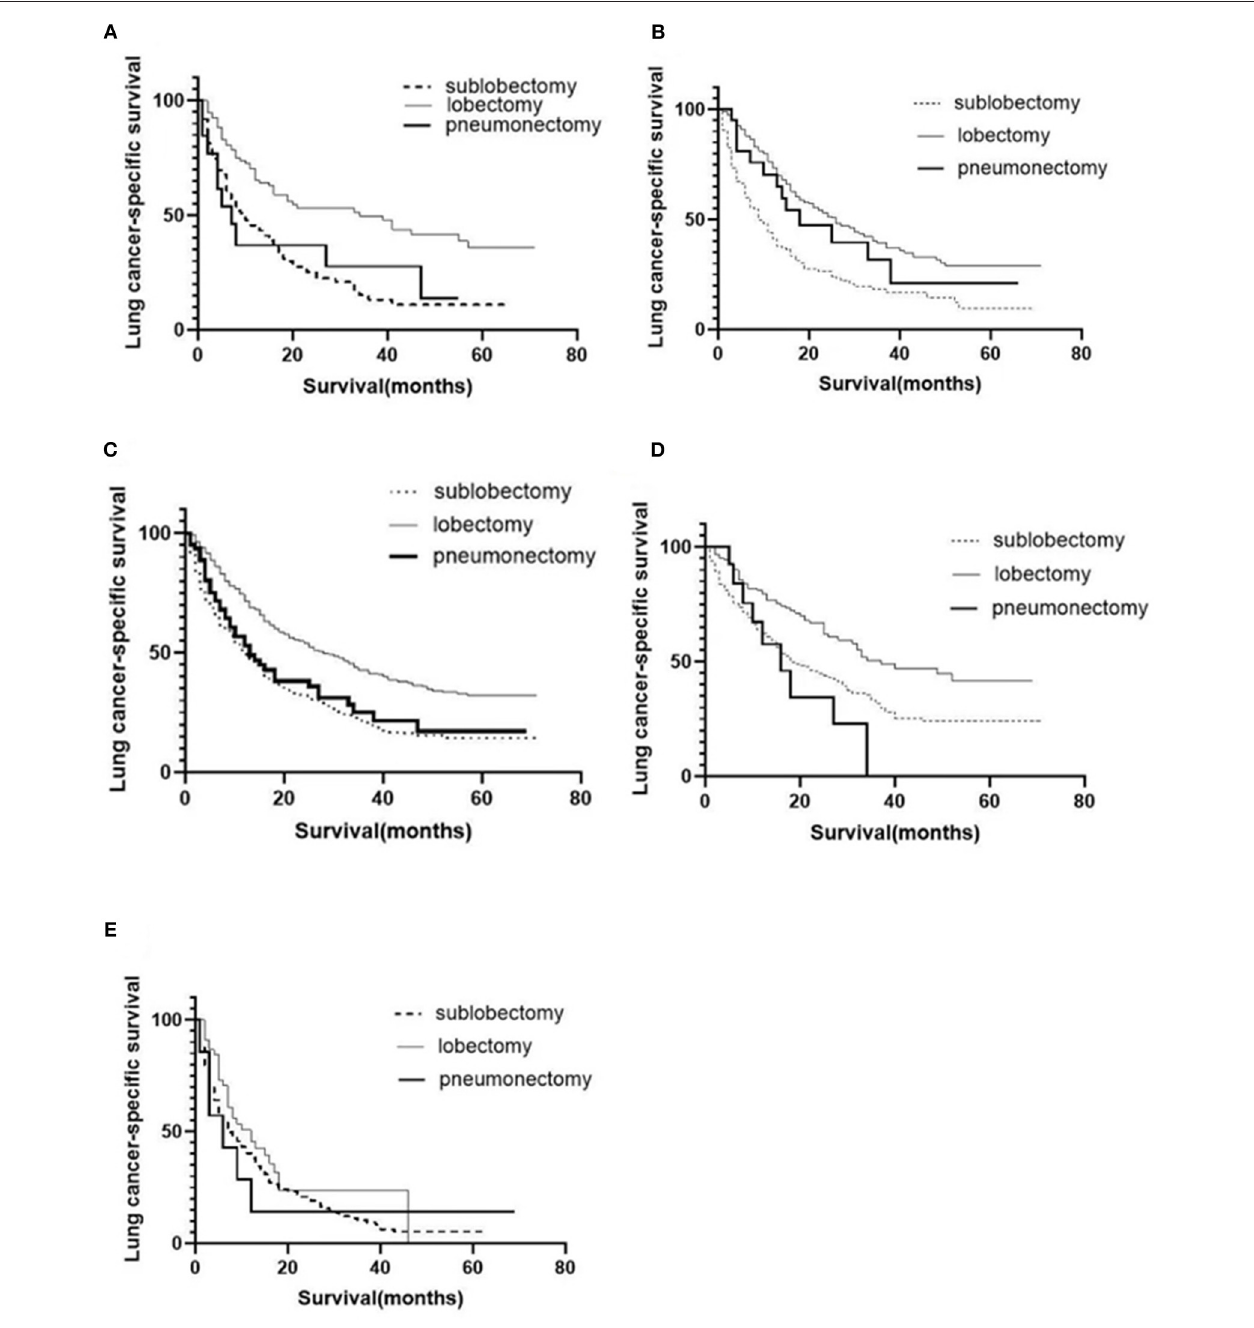
FIGURE 3 | Postoperative LCSS curves of patients receiving different surgical procedures after classification by organs involved. LCSS curves of bone metastasis (A) ; brain metastasis (B) ; liver metastasis (C) ; lung metastasis (D) ; multiple metastases (E) .